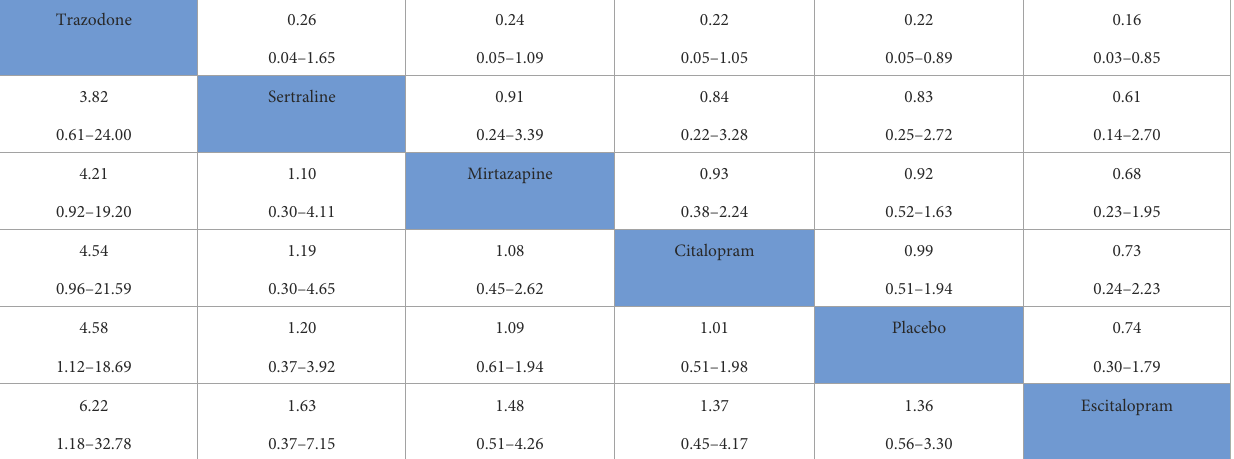
TABLE 2B League table for antidepressant drug